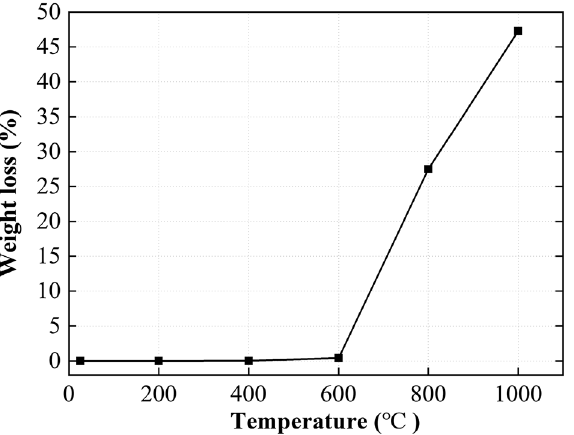
Figure 3. Measured weight loss of the marble samples exposed to different treating